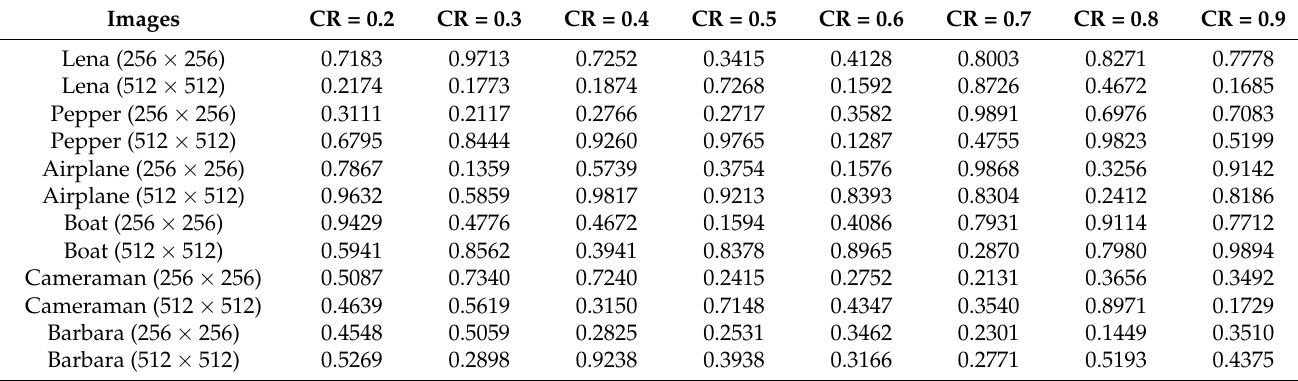
Figure 6. The number of pixels change rate (NPCR) and unified average changing intensity (UACI) test result. ( a , c ) show the results of images with the size of 256 × 256. ( b , d ) show the results of images with the size of 512 × 512. ( a , b ) show the results of NPCR tests. ( c , d ) show the results of UACI tests. Table 4. Histogram uniformity evaluation by chi-squared test ( p